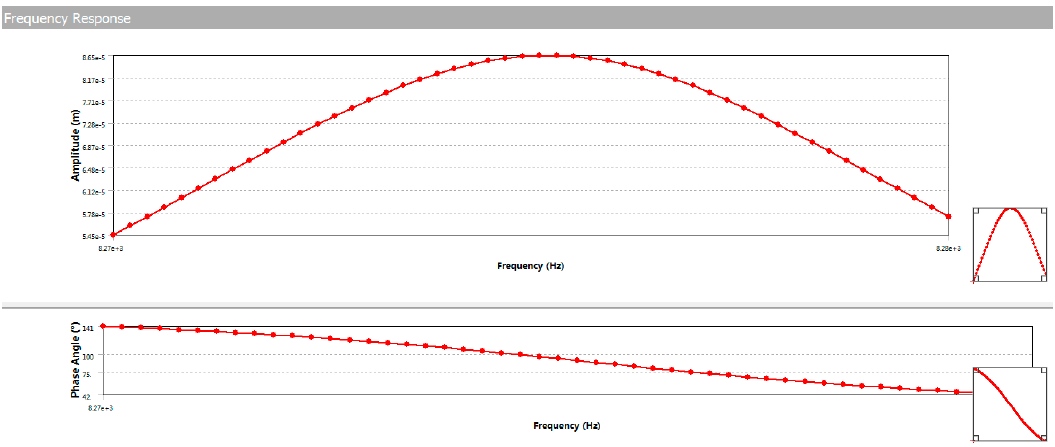
Figure 12. Harmonic response simulation results of the MEMS resonator.